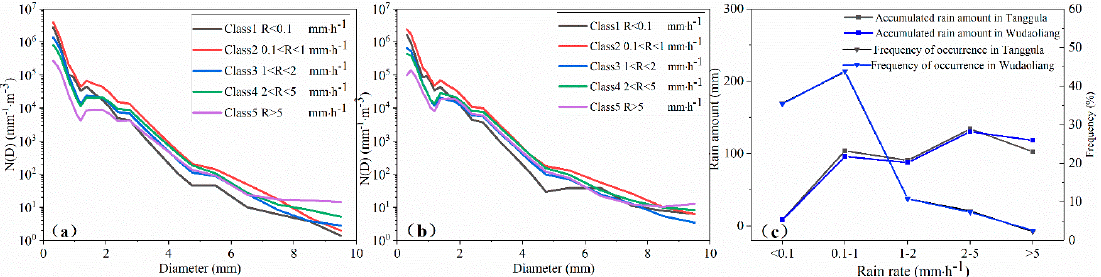
Figure 8. ( a , b ) Variation in particle concentration with size and ( c ) amount of accumulated precipitation with rain rate for different rainfall rates at Tanggula and Wudaoliang.